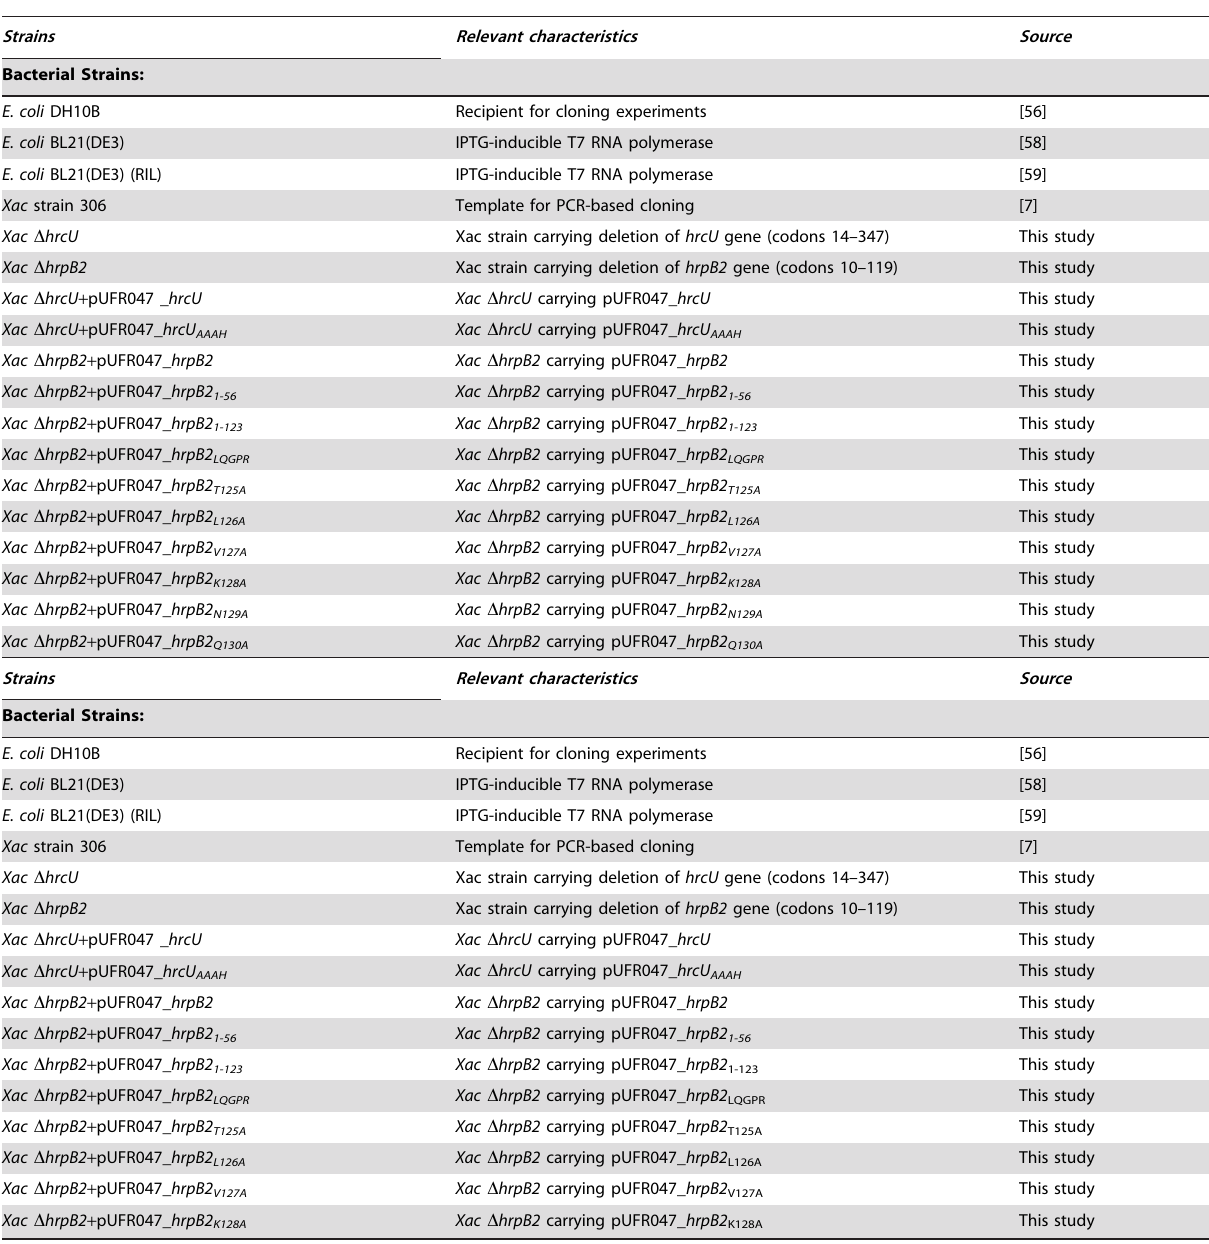
Table 1. Strains used in this